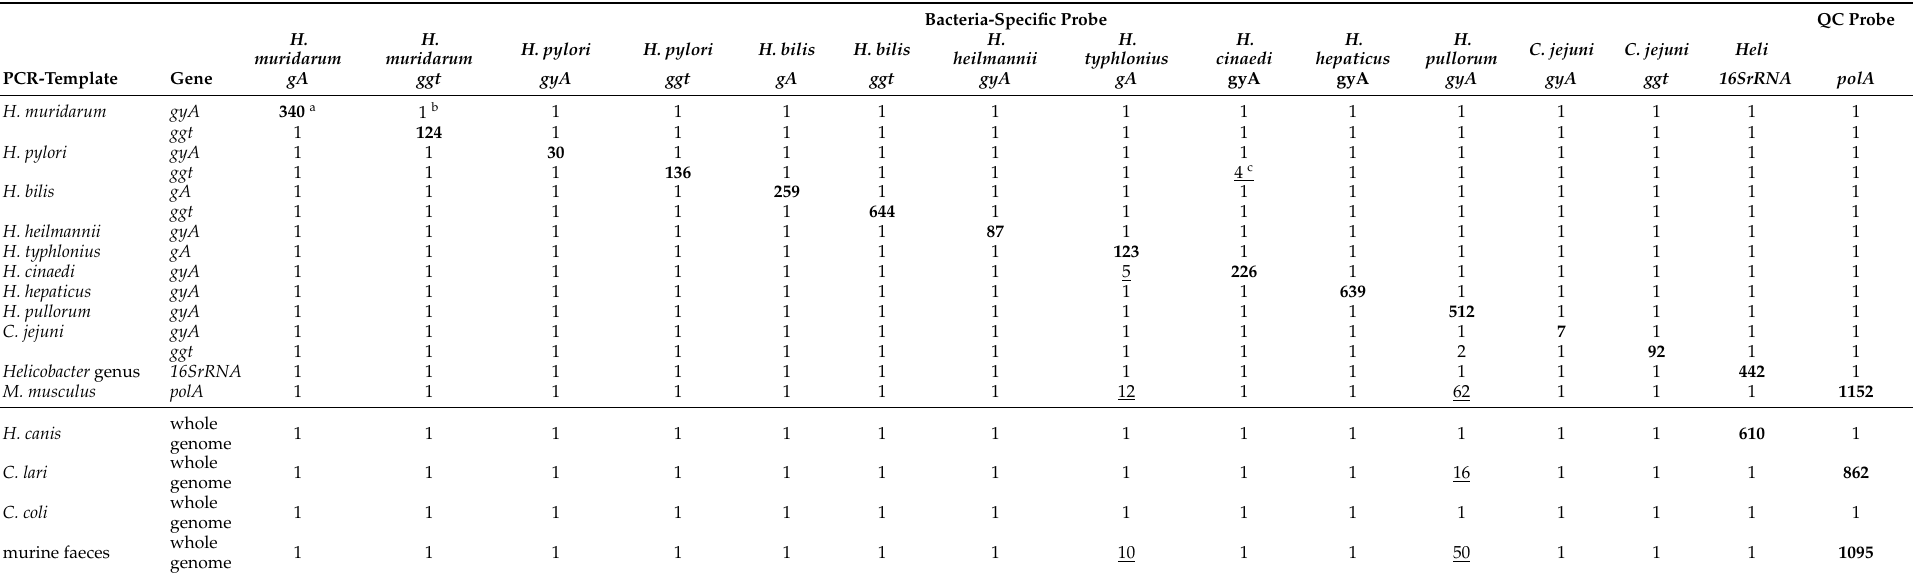
Table 4. Analytical specificity of Helicobacter multiplex DNA